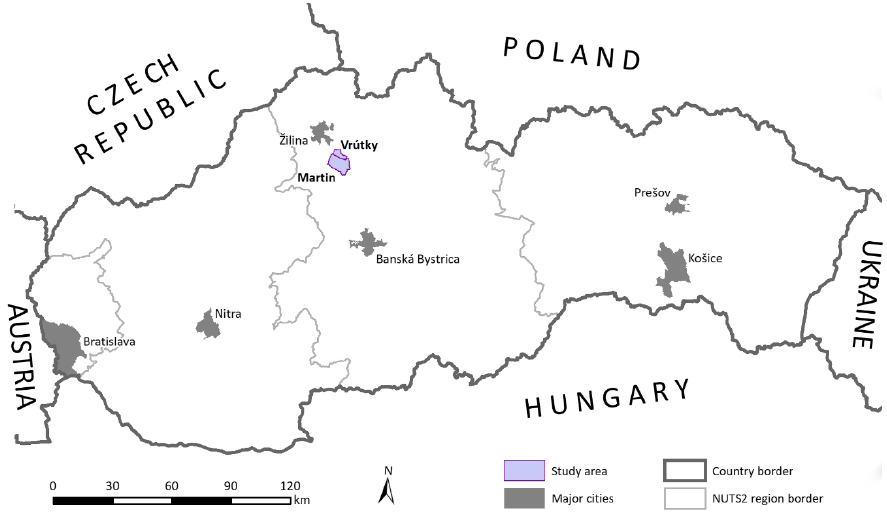
Figure 1. The location of the study